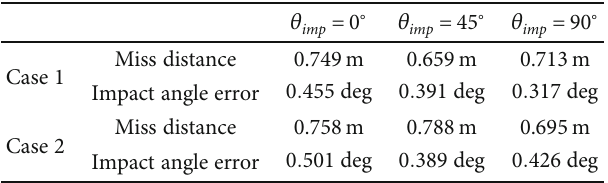
Table 2: Mean miss distances and impact angle errors of 50 runs Monte-Carlo